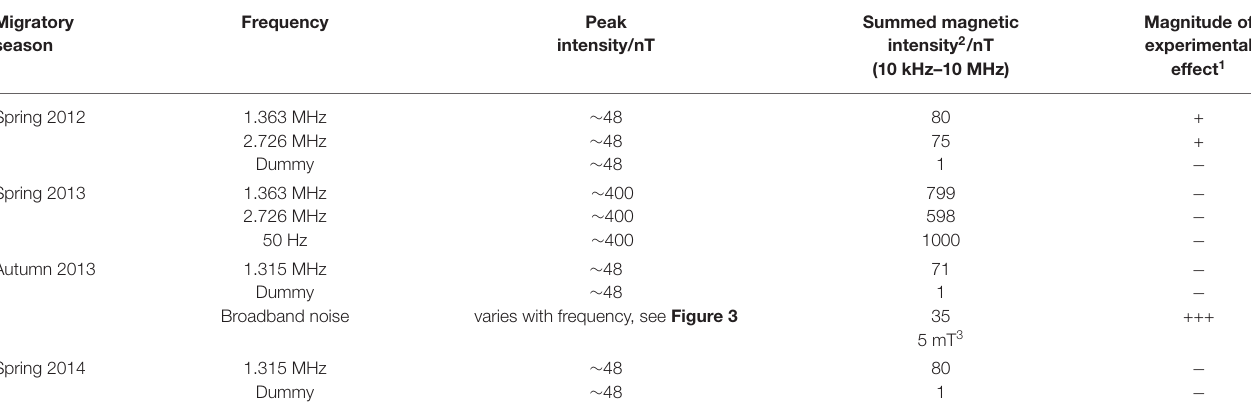
TABLE 1 | Measured time-dependent magnetic field intensities .